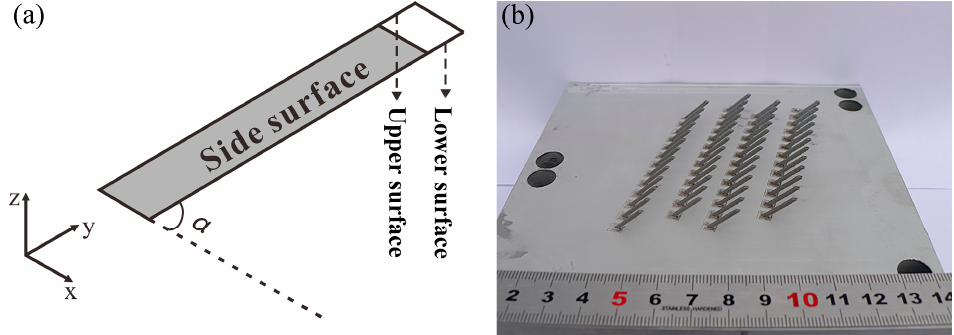
Figure 1. Detail of original CAD model ( a ) and the image of the samples ( b ). Table 2. Processing parameters used in this study. Processing Parameters